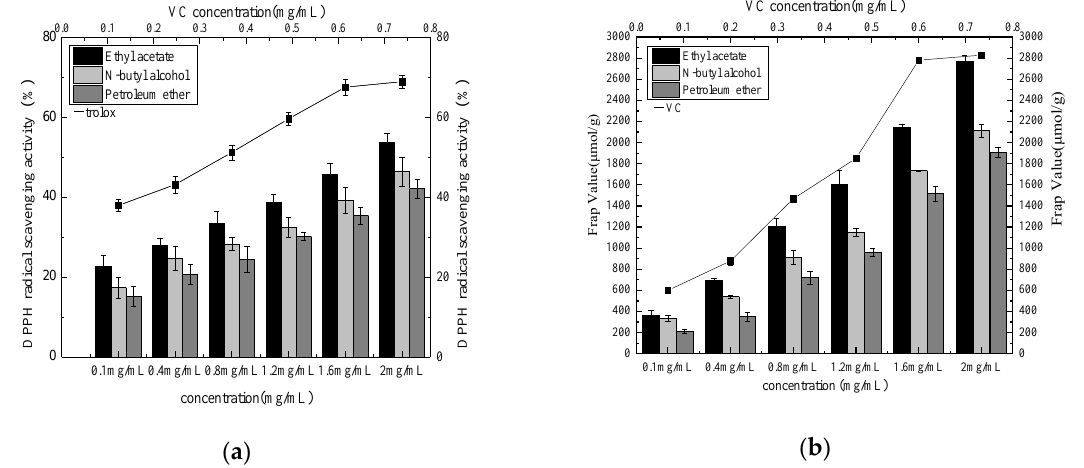
Figure 9. DPPH radical scavenging activity of different extraction phases ( a ) and FRAP value of different extraction phase ( b ). Table 11. Scavenging effect of Pleioblastus amarus (Keng) shell with different extraction phases on DPPH free radical.